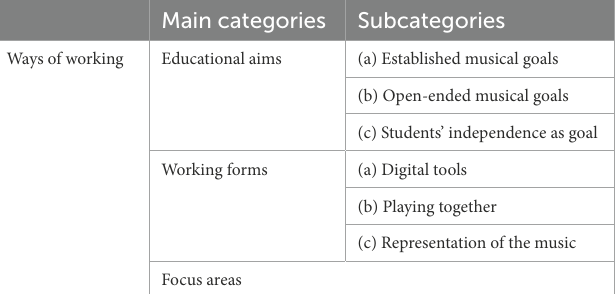
TABLE 1 Categories of Ways of Working , constructed through analyzing the data material from the teacher survey. Main